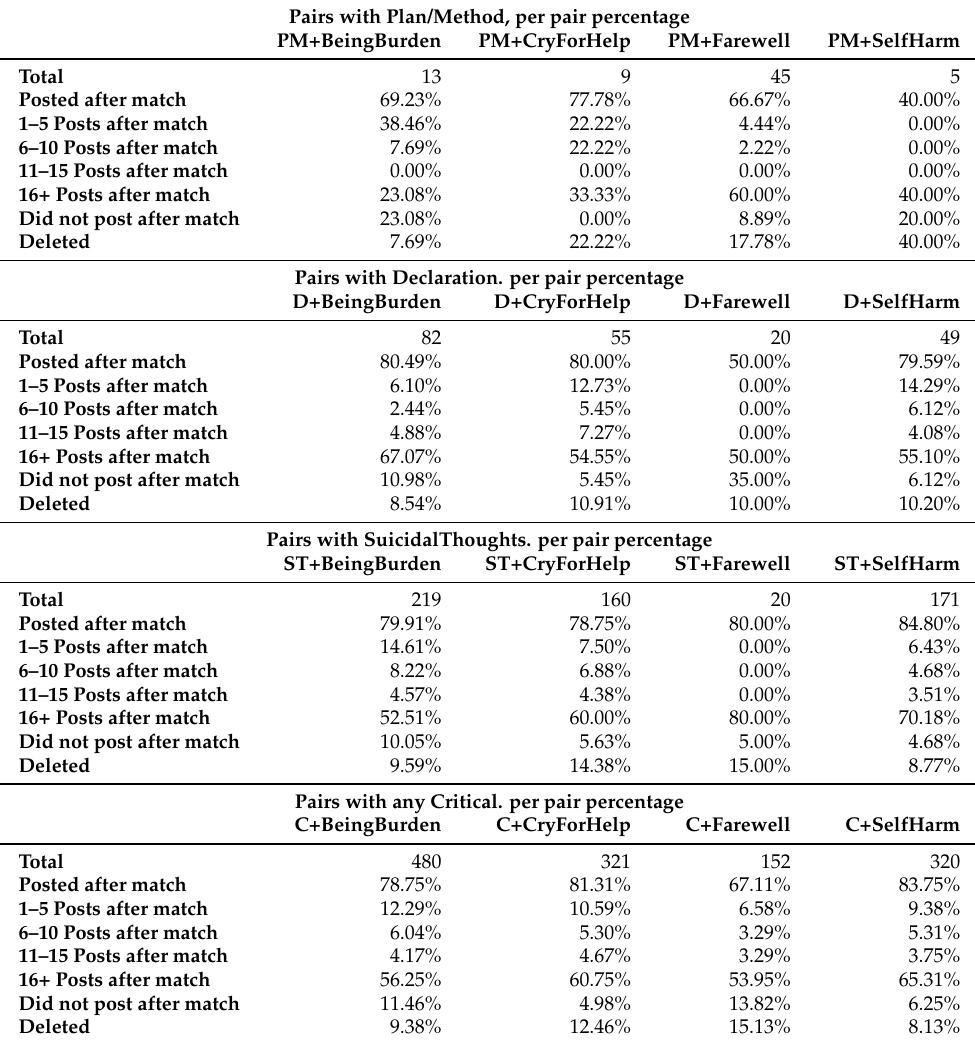
Table 6. Distribution of user activity among combinations of the supporting speech acts Being Burden, Cry for Help, Farewell and Self-harm with critical speech acts.